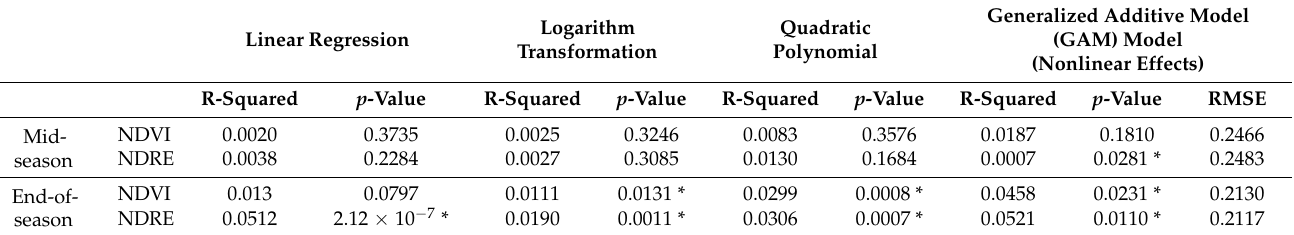
Table 2. Linear models compared with nonlinear models for nitrogen content modeling with normalized difference red edge (NDRE) and normalized difference vegetation index (NDVI). Results showed both mid-season and end-of-season. p -values with * are significant.